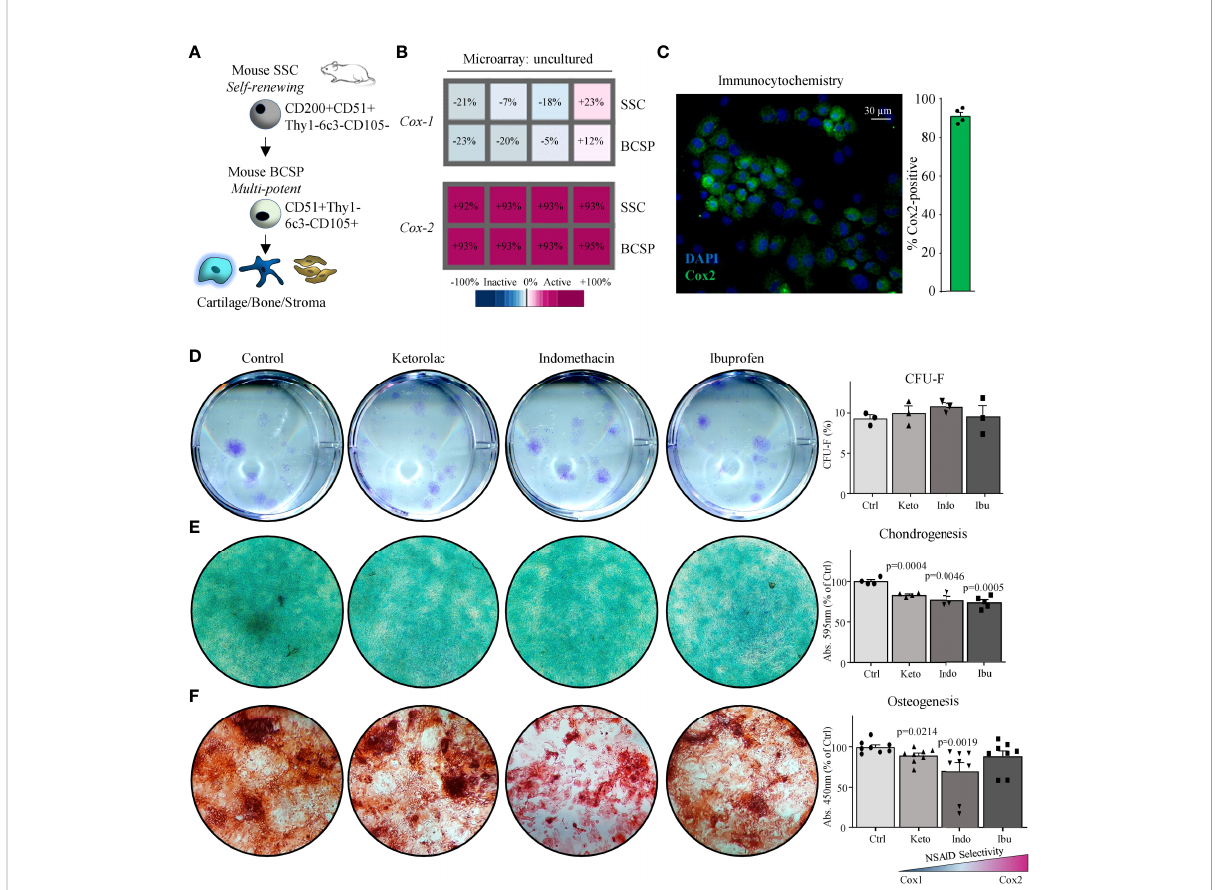
FIGURE 1 Mouse skeletal stem cells depend on Cox2 for functional osteochondrogenic differentiation. (A) The mouse skeletal stem cell (SSC) lineage tree as de fi ned by surface marker expression pro fi les with the SSC at the apex and the downstream bone cartilage stroma progenitor (BCSP) which gives rise to committed bone, cartilage, and stroma progenitor cells. (B) Microarray analysis showing Cox-1 and Cox-2 expression of freshly puri fi ed SSCs and BCSPs from fracture calluses of four different mice. (C) Representative immunocytochemistry (ICC) staining of Cox2 of fracture-derived SSCs expanded in culture for fi ve days. (D) Representative images of colony-forming unit assays of fracture-derived SSCs stained with Crystal Violet expanded in the absence or presence of NSAIDs (left; Ketorolac 0.3 µg/ml, Ibuprofen 3 µg/ml, or Indomethacin 0.3 µg/ml) and quanti fi cation thereof (right). Replicates from n=3 mice. (E) Representative images of chondrogenesis assays of fracture derived SSCs stained with Alican Blue differentiated in the absence or presence of NSAIDs (left) and quanti fi cation thereof (right). Replicates from n=4 mice. (F) Representative images of osteogenesis assays of fracture derived SSCs stained with Alizarin Red S differentiated in the absence or presence of NSAIDs (left) and quanti fi cation thereof (right). Replicates from n=4 mice. All data shown as mean + standard error of mean (SEM). Results from at least two independent experiments. Statistical testing versus control group by unpaired Student ’ s t-test with Welch ’ s correction for unequal variances and Mann-Whitney test for non-normality where